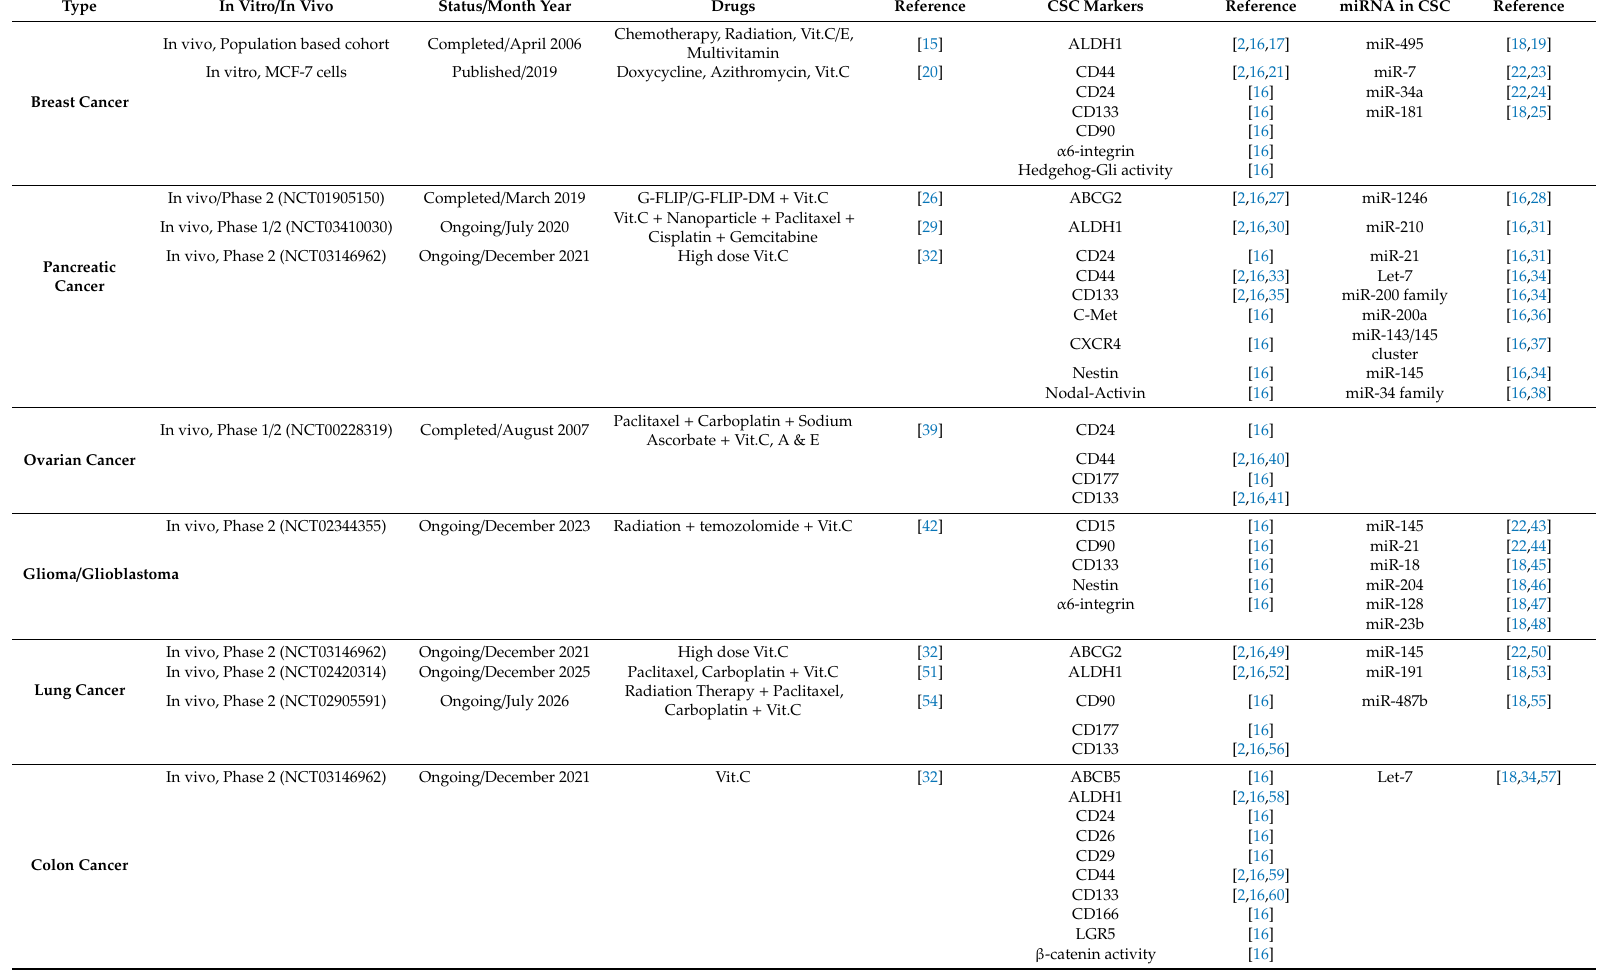
Table 1. Current research status on the e ff ect of Vit.C on various cancer types. It also represents the various cancer stem cells (CSC) markers and miRNA associated with various cancer